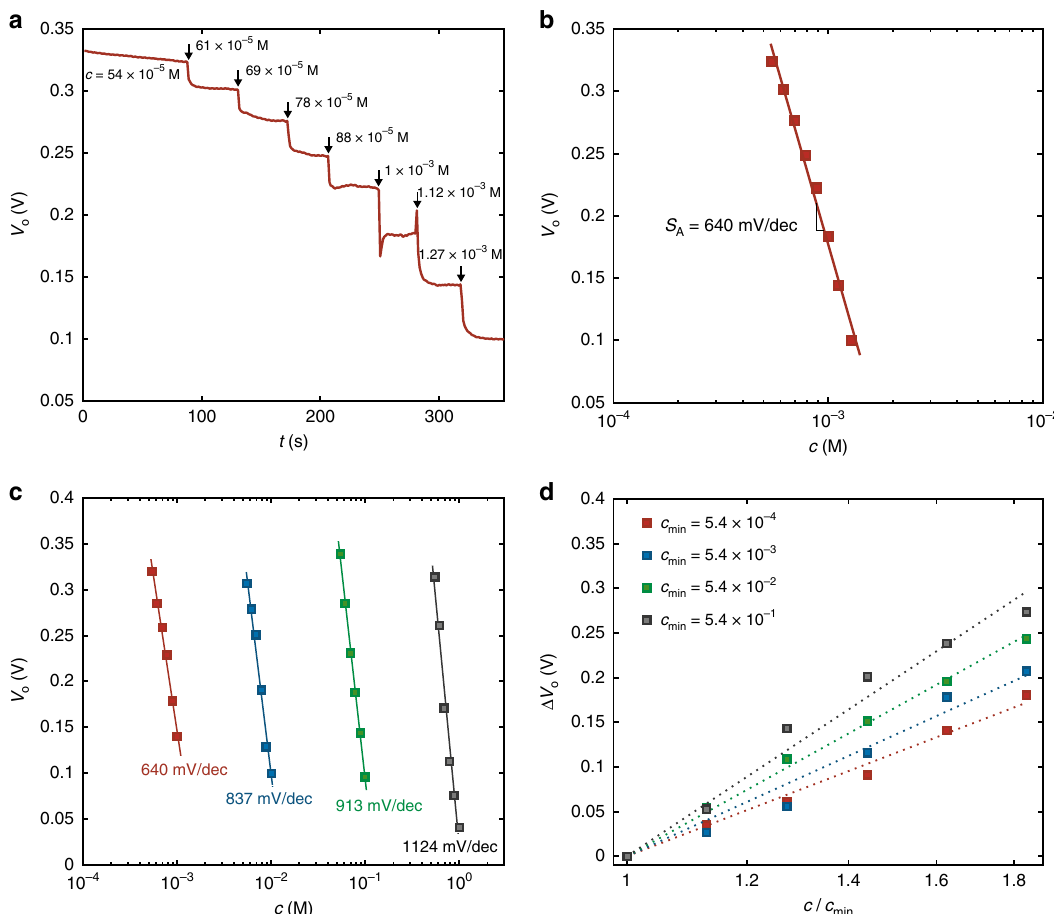
Fig. 4 Real time high sensitivity operation. a Real time high-sensitivity ion detection in the concentration range 54 × 10 − 5 M – 1.27 × 10 − 3 M. The electrolyte concentration is increased every 30 s. The measurements are performed at V M = 0.415 V. b Measured steady-state output voltage V O (symbols) as a function of ion concentration c . Full red line is the linear least square fi t to the measurements and yields a sensitivity S A = 640 mV dec − 1 . c Measured V O as a function of c in various sub-range of concentrations, covering the whole physiological range. The ion concentration where V O = V DD / 2 is c 0 = [7.8 × 10 − 4 , 7.8 × 10 − 3 , 7.8 × 10 − 2 , 7.8 × 10 − 1 ] M. Full lines are the linear least square fi t to the measurements, yielding S A . d Measured (symbols) output voltage variation Δ V O = V O ( c ) - V O ( c min ) as a function of c / c min , where c min = [5.4 × 10 − 4 , 5.4 × 10 − 3 , 5.4 × 10 − 2 , 5.4 × 10 − 1 ] M. Dotted lines are guides for the